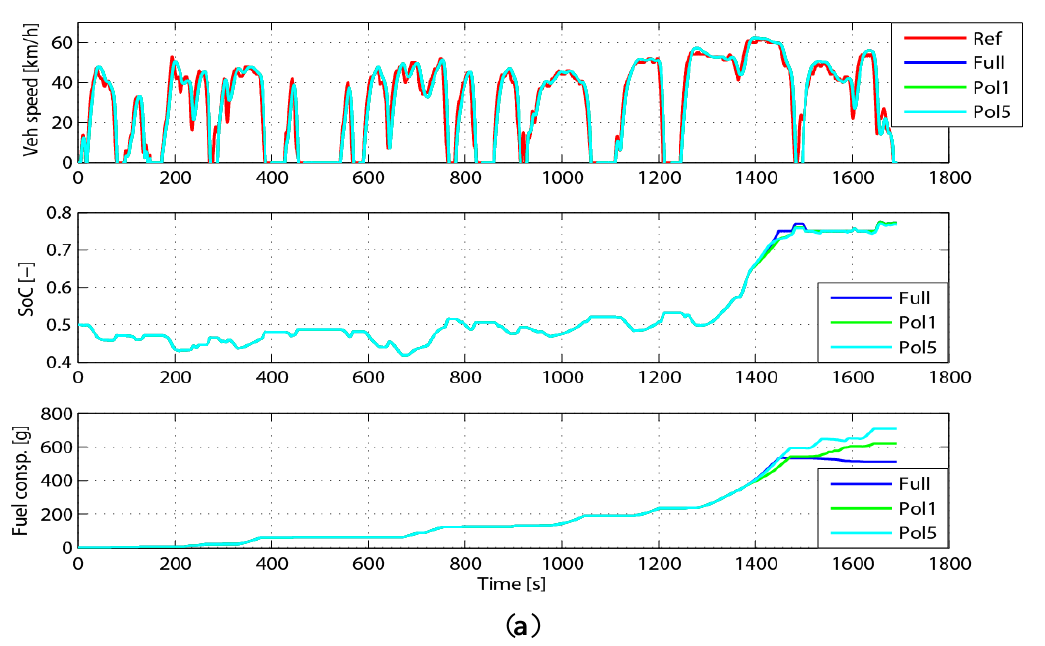
Figure 16. Comparison of the full-policy and a fixing single policy-1, single policy-5 in the third Tuesday speed profile. ( a ) Vehicle speed, SoC and fuel-electricity consumption; ( b ) engine operating point